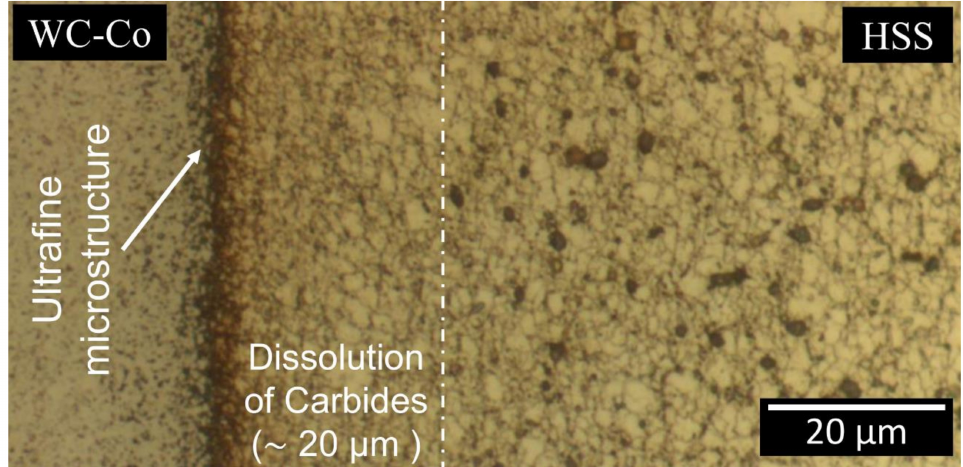
Figure 12. Optical image of the weld interface after chemo-mechanical polishing and chemical etching (Murakami’s 20 s and Nital 60 s).